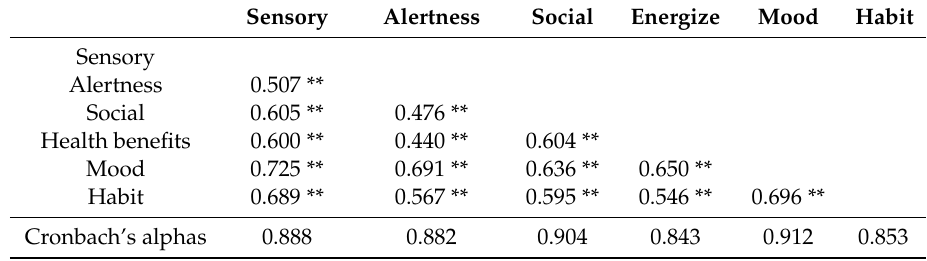
Table 5. Correlations between the factors and internal